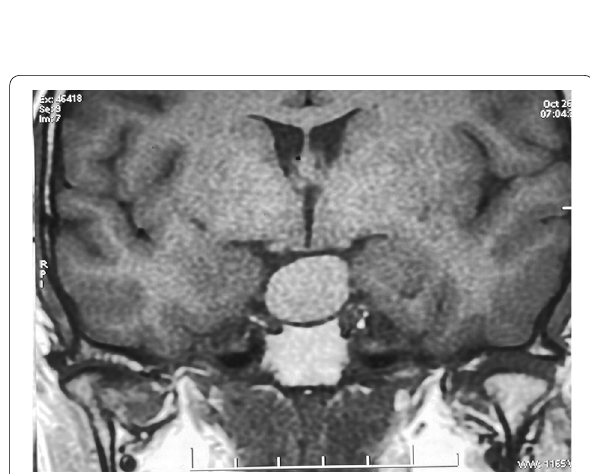
Fig. 6 MRI brain T1 coronal image showing the entirely suprasellar location of the cystic